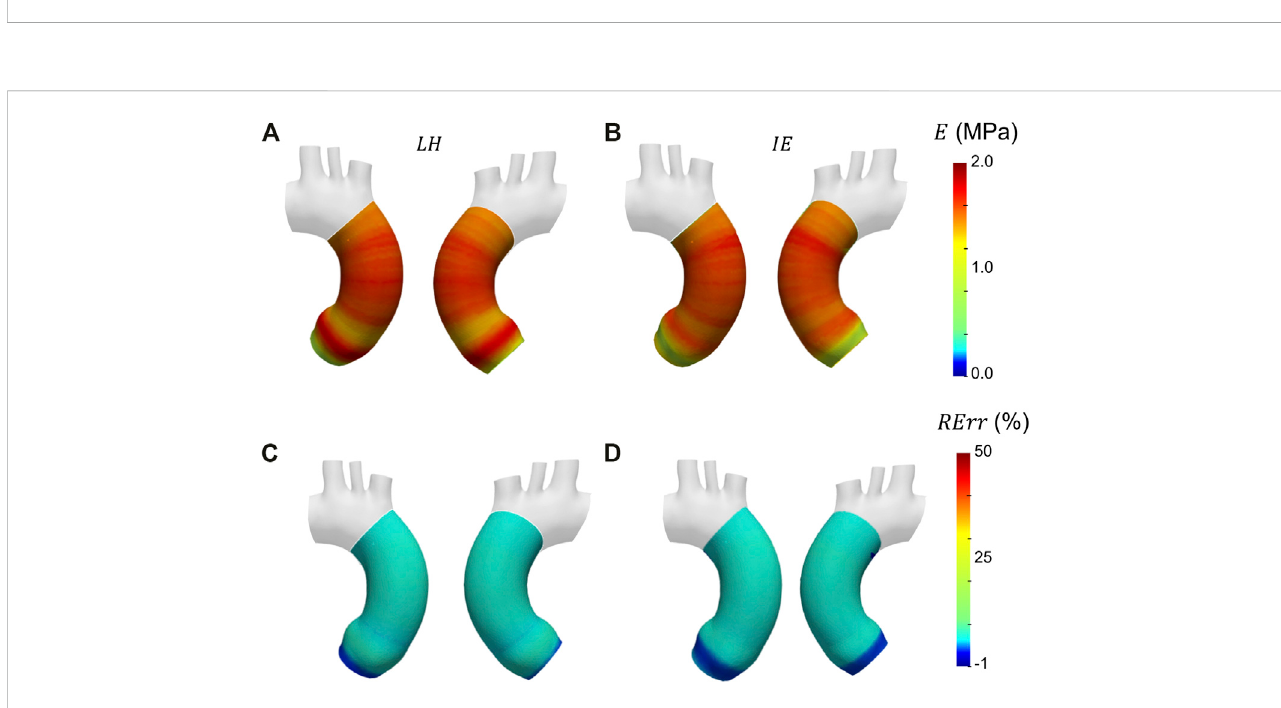
FIGURE 7 Young ’ s modulus maps of FE validation for patient-speci fi c geometry with homogeneous distribution with (cid:1) E H θ (cid:2) 1.75 MPa (A, B) with corresponding relative errors (C, D) . Both Laplace-hypothesis-based ( E LH θ ) (A, C) and inverse-engineering-based ( E IE θ ) (B, D) results are